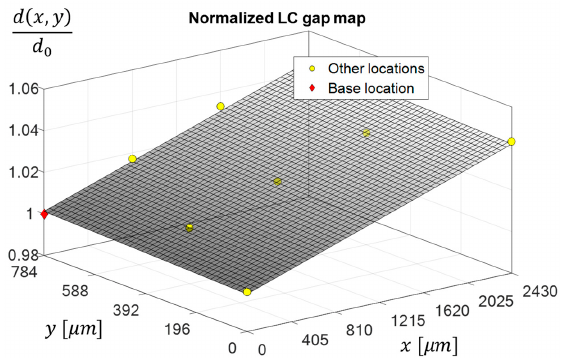
Figure 11. The normalized estimated LCC gap map obtained in the experiment. The base location is marked with a red diamond and the other locations with yellow circles. The map was formed at a single randomly-chosen voltage. d 0 is the gap at the base location, and all other gap values are normalized by it.